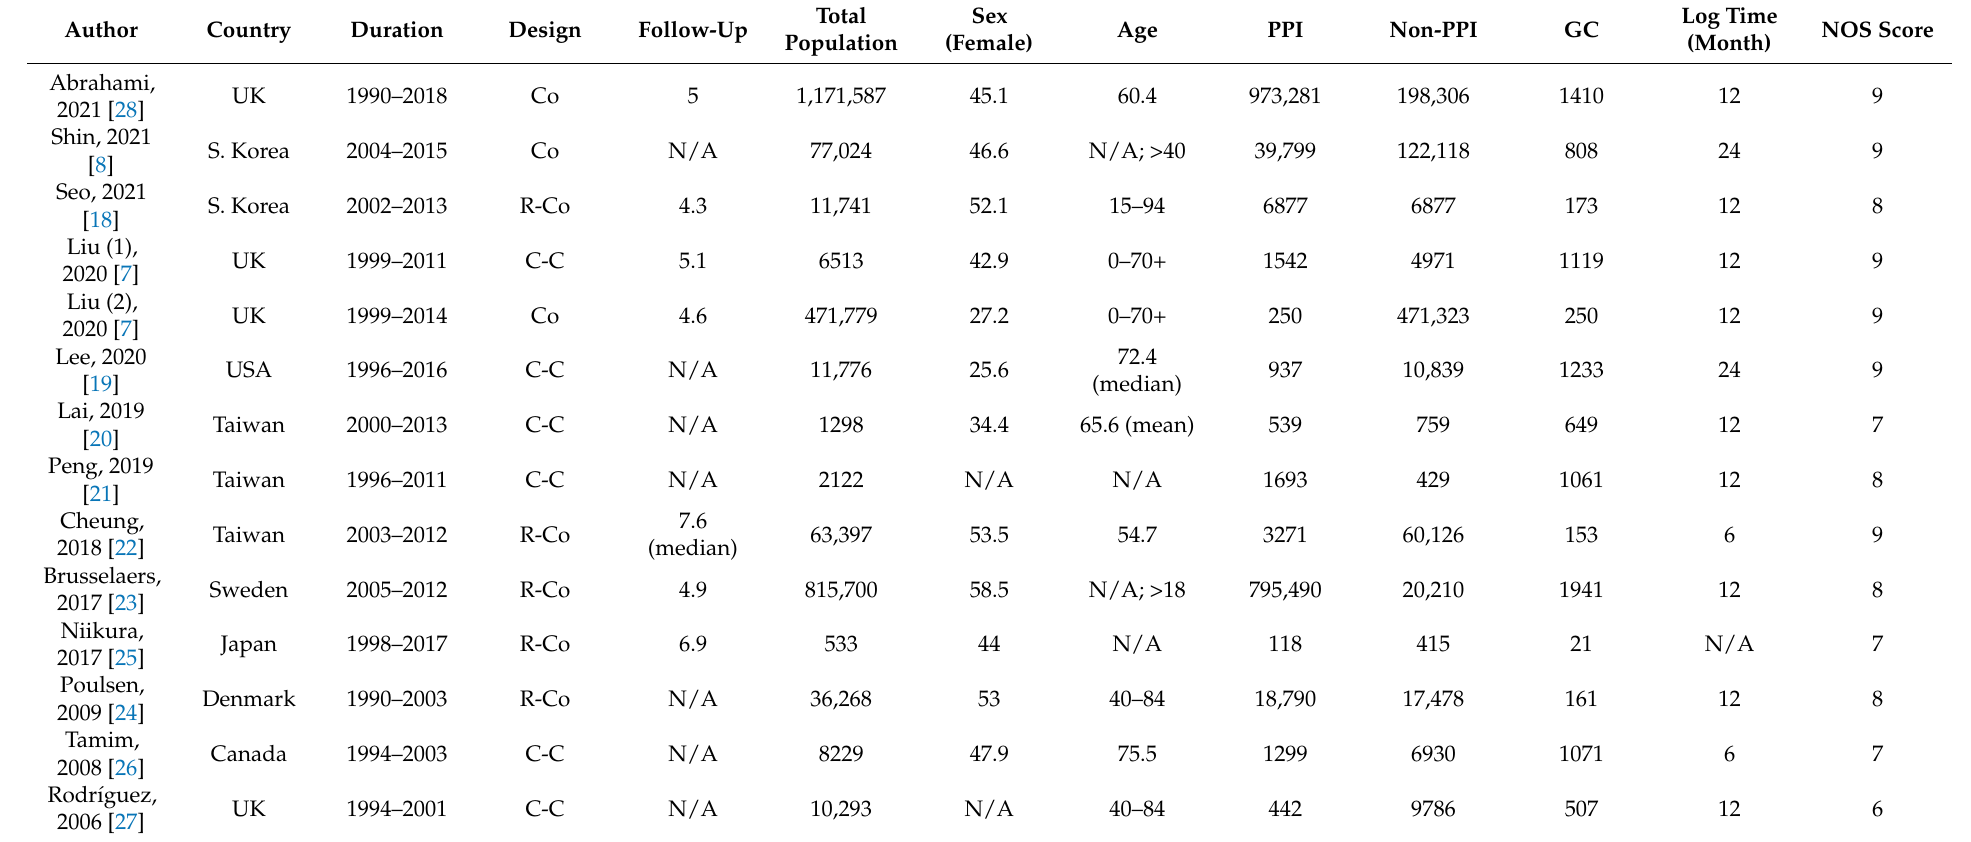
Table 1. Characteristics of the included